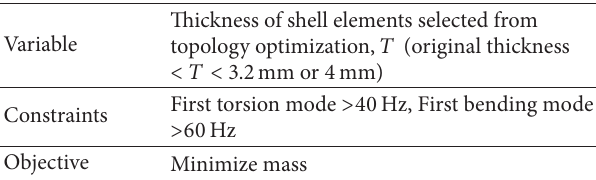
Table 4: Criteria of size optimization depending on topology